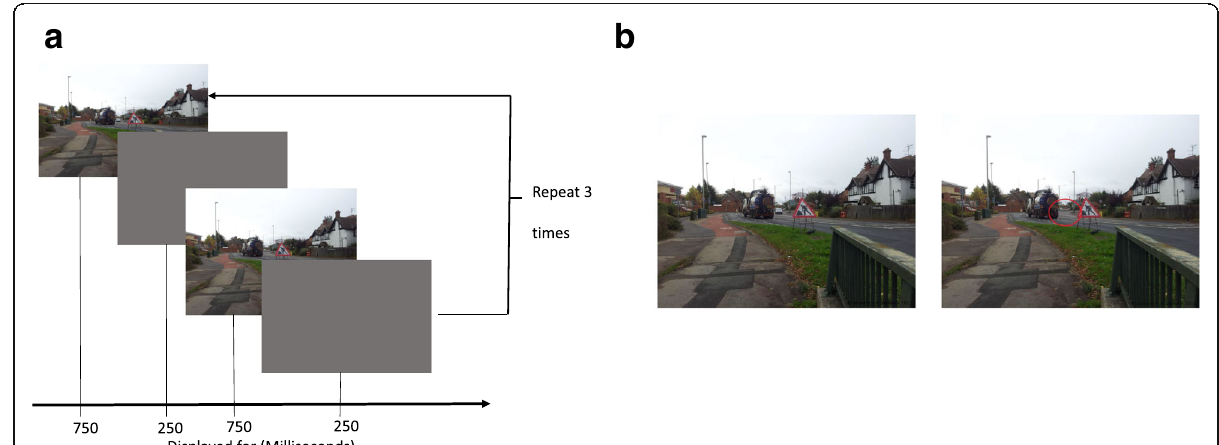
Fig. 1 Example of the procedure for a single change blindness demonstration. a Participants viewed the interleaved images for a total duration of 6 s. b Following this, the instructor clicked on a “ display the change ” button which presented the two images side by side, with the change highlighted by an outline